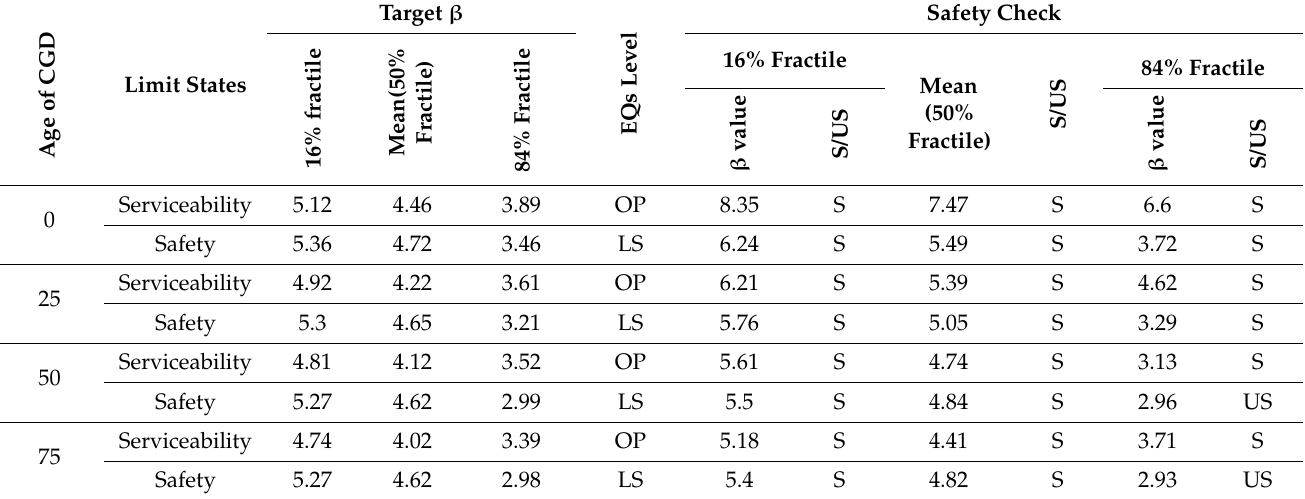
Table 4. Safety check range for the seismically induced